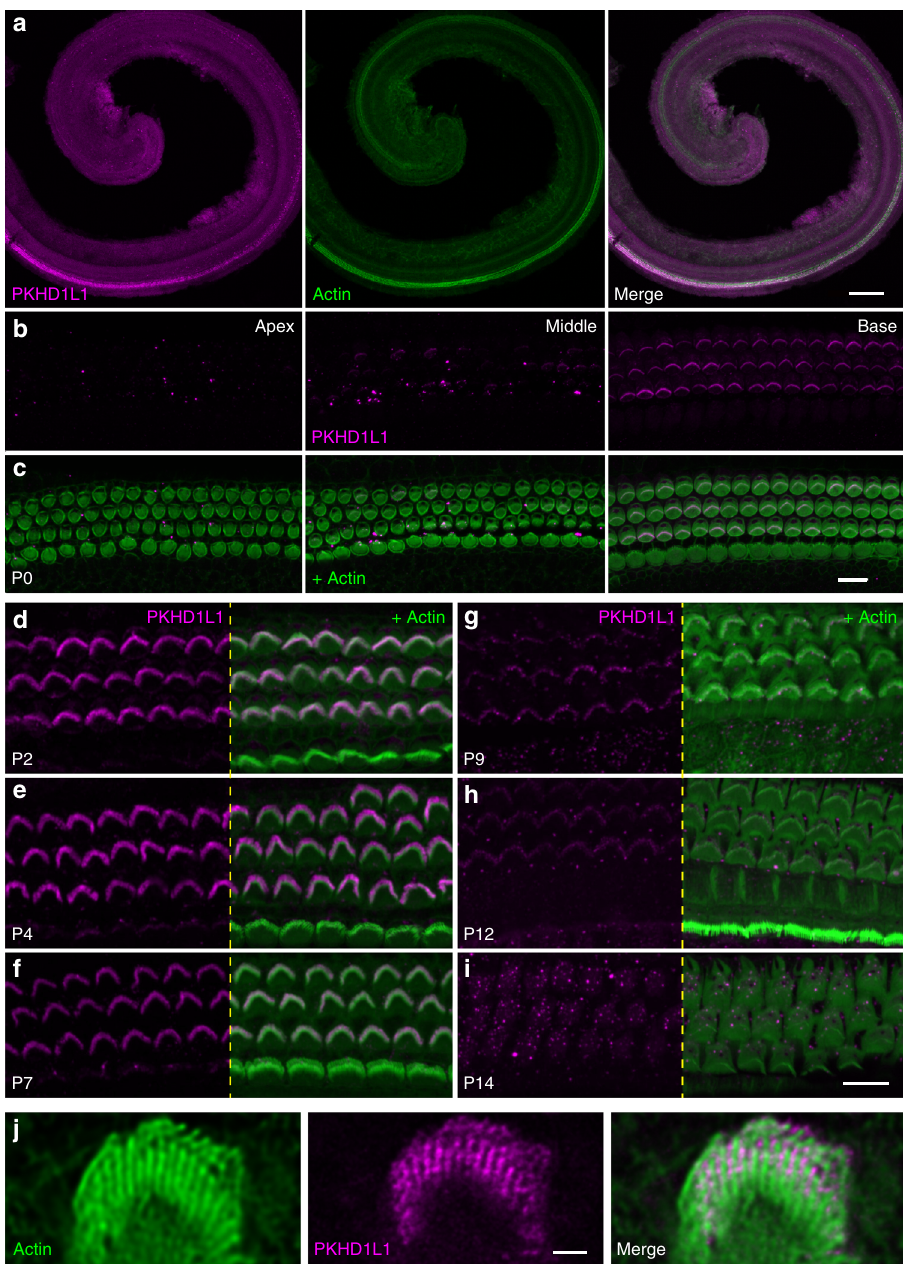
Fig. 3 PKHD1L1 protein levels in hair cells of Pkhd1l1 fl / fl , Atoh1-Cre − in early postnatal animals. a Confocal images of cochlear whole mounts with anti- PKHD1L1 labeling (magenta), and phalloidin (green; staining fi lamentous actin) at P0. Note the more abundant anti-PKHD1L1 signal in the base of the cochlea. b , c PKHD1L1 expression levels in P0 cochlea in three locations: apex ( left ), middle turn ( middle ), and base ( right ). c The phalloidin signal (green) is superimposed to visualize stereocilia bundles. d – i Strong anti-PKHD1L1 labeling is evident in OHC stereocilia bundles at P2 – P7 d – f , decreasing from P9 to P12 g , h , and no longer detected with fl uorescence within the bundles at P14 i . All images were collected from the mid-cochlear location. Anti-PKHD1L1 in magenta, phalloidin in green. j Stimulated Emission Depletion (STED) microscope imaging of PKHD1L1 labeling (magenta) on OHC stereocilia bundles at P7, combined with the phalloidin (green). Scale bars: a , 150 µ m; b – i , 10 µ m; j , 1 µ density (gold count per segment area, per cilium) is presented in shortest rows, respectively (mean ± SD). To quantify the labeling Fig. 5d, where the color coding re fl ects the density values across density per unit area, we divided each stereocilium into 200-nm the data set. For all three rows of stereocilia, gold bead density segments along the length (12, 10, and 6 segments for the tallest, was signi fi cantly higher at the tips of stereocilia and enriched at middle, and shortest rows, respectively). We further divided each the negative side of the tips for the middle and shorter row segment into four radial sectors (anterior, posterior, and two stereocilia, whereas more uniformly distributed around the tip of lateral). The area of each segment, although of the same height, the tallest ones. Gold beads were also observed at the surfaces of varied among the rows because of the difference in stereocilia kinocilia, although they were omitted from our analysis owing to diameter, resulting in 0.025, 0.028, and 0.021 µm 2 for the tallest, middle, and shortest rows respectively. Normalized labeling a relatively low number of beads and kinocilia ( n = 6).